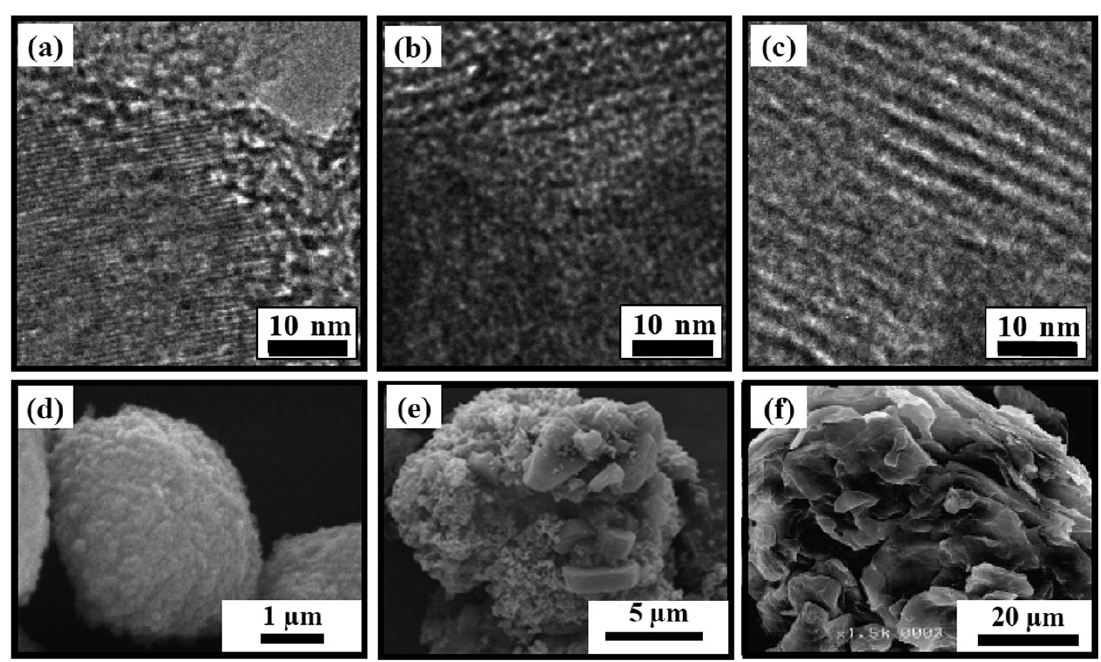
Fig. 3 Morphology and texture of different types of recrystallized zeolites studied by TEM (a, b, c) and SEM (d, e, f) over RMOR-1 (a), RMOR-2 (b), RMOR-3 (c) and Figure 7. TEM images of mordenite/MCM-41 composites ( a – c ) and SEM images of MFI/MCM-41 RMFI-1 (d), R-MFI-2 (e), RMFI-3 (f). Adapted with permission from ref. 29 (a, b, c) r 2012 Elsevier, from ref. 32 (e) r 2002 Springer, from ref. 41 (f) r 2004 Elsevier. composites ( d – f ) obtained at various degrees of recrystallization of mordenite and ZSM-5 respectively. Reproduced with permission from [28]. Copyright Royal Society of Chemistry,